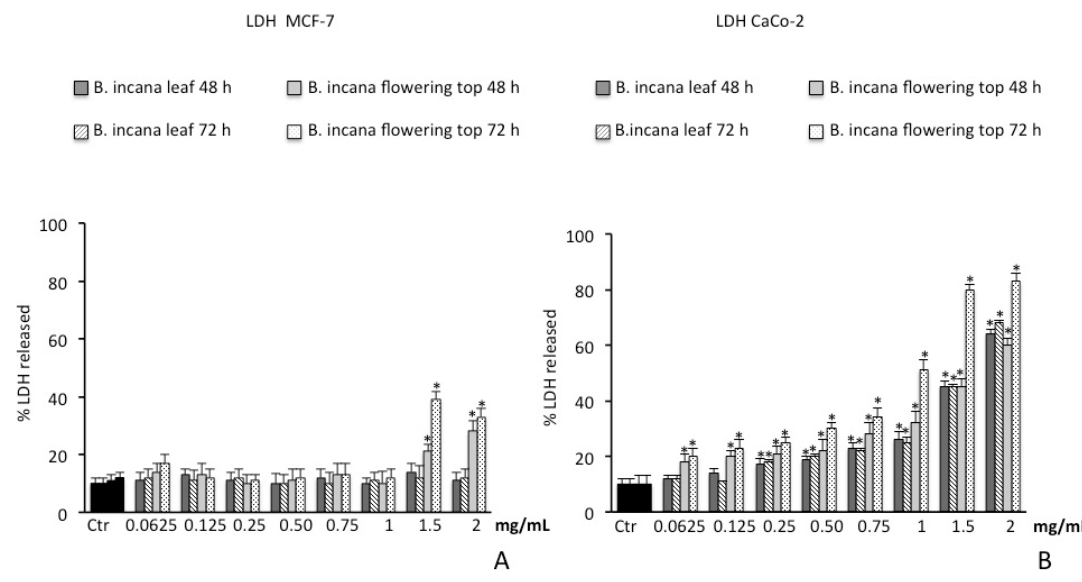
Figure 5. Lactic dehydrogenase (LDH) released in MCF-7 ( A ) and CaCo-2 ( B ) cells untreated and treated for 48 h and 72 h with B. incana leaf and flowering top hydroalcoholic extracts. Values are the mean ± SD of four experiments in triplicate. *Significant vs. untreated control cells: p < 0.001. Conversely, on CaCo-2 cell lines, a time- and dose-dependent LDH release was pointed out by the experimental model for both extracts. In particular, the necrotic e ff ect is more evident for the B. incana flowering top extract after 72 h of exposure, being significant from the concentration of 0.0625 mg /